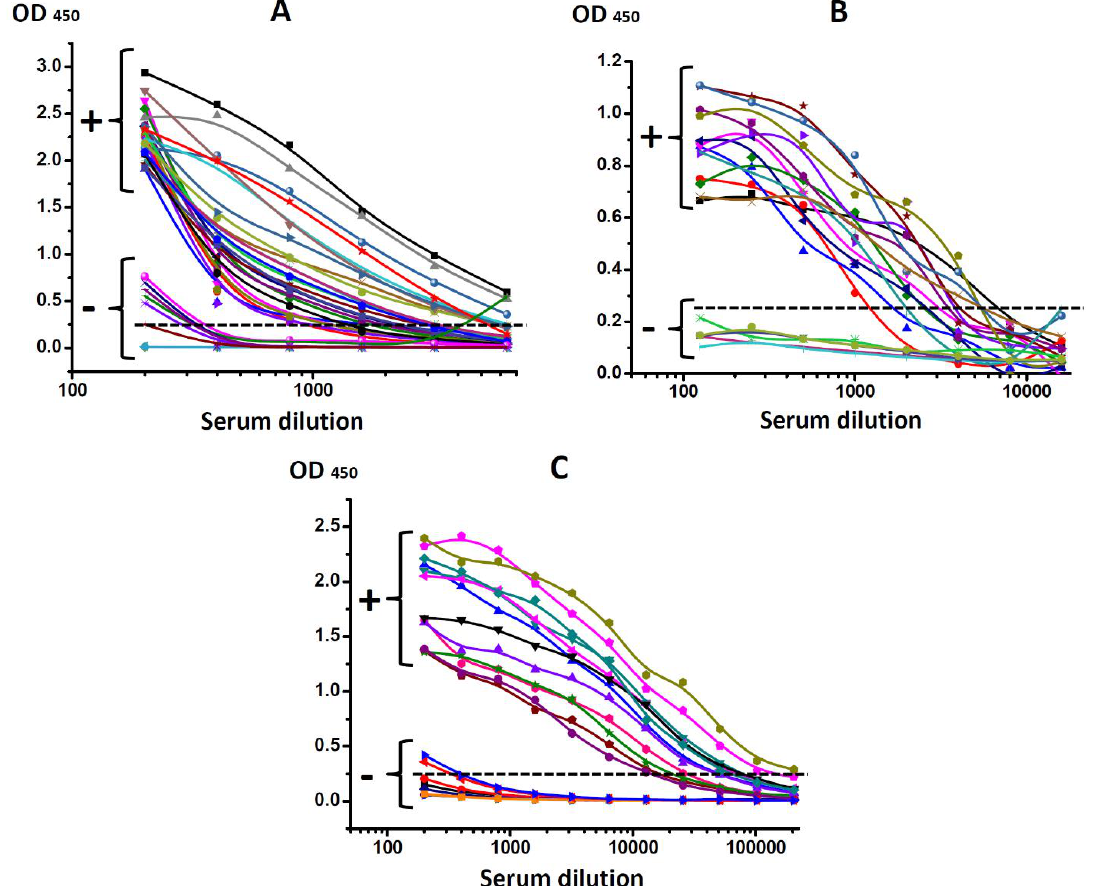
Figure 2. Testing of bovine sera obtained from healthy (-) and infected animals (+) diagnosed with ( A ) leukemia (BLV); ( B ) brucellosis ( Br. abortus) ; ( C ) tuberculosis ( M. bovis ).